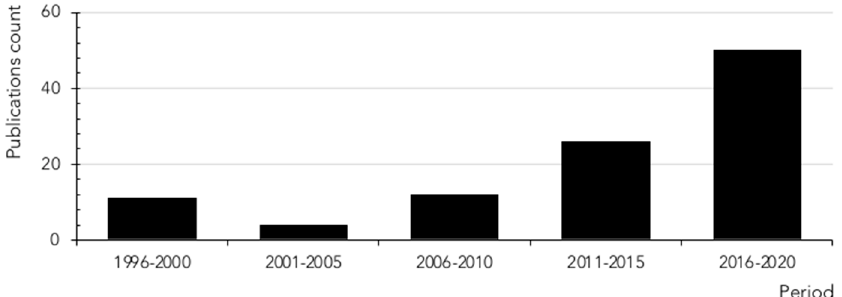
Figure 5. Count of scientific publications containing the keywords histamine intolerance or histaminosis, according to a search performed through the PubMed search engine at the MEDLINE bibliographic database (search performed in July 2020).